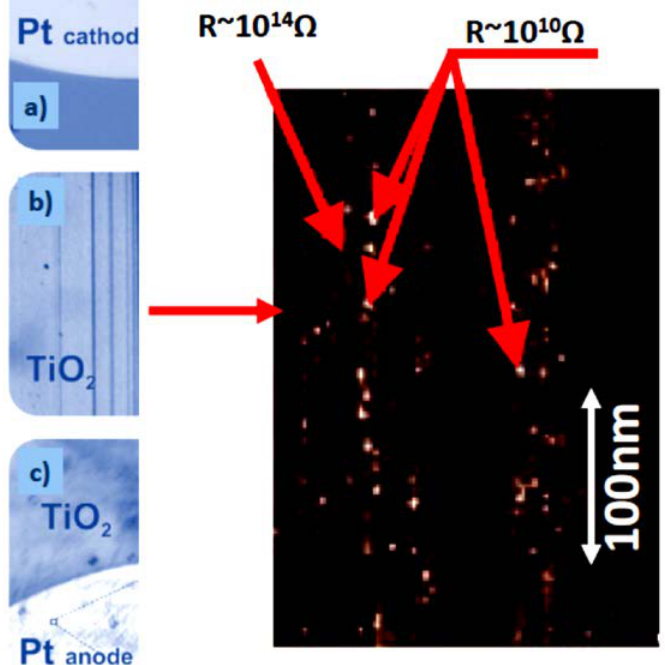
Figure 61. LCAFM measurements (in-plane) on electrodegraded TiO 2 (110) crystals. Polarization ~100 mV temperature below 300 °C. Adapted from [53,68].